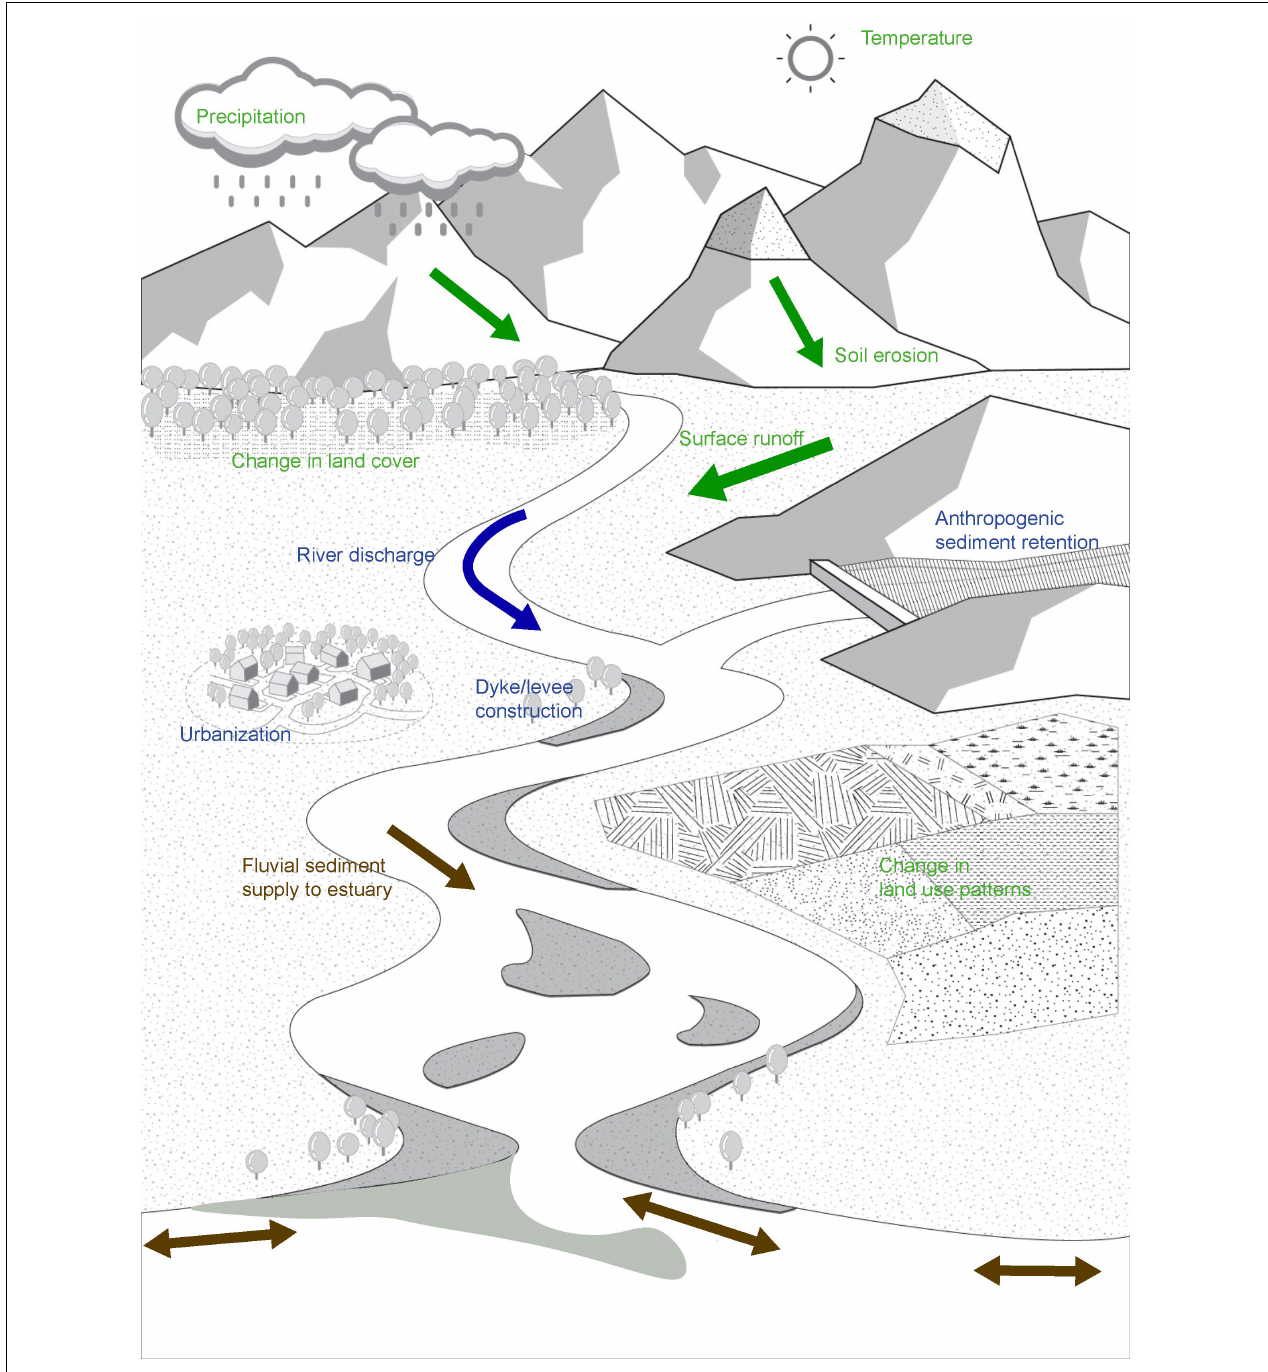
FIGURE 1 | Schematic representation of the sediment pathway from source to the coast. The three colors used in the figure denote the major components (i.e., zones) related to this sediment pathway: (1) catchment-scale sediment production zone fed by soil erosion (in green), (2) transition zone of sediment throughput (in blue), and (3) deposition and redistribution zone dominated by sediment exchange between the estuary and its adjacent coast (in brown). Two-way arrows in brown denote sediment exchange between the estuary and its adjacent inlet-interrupted